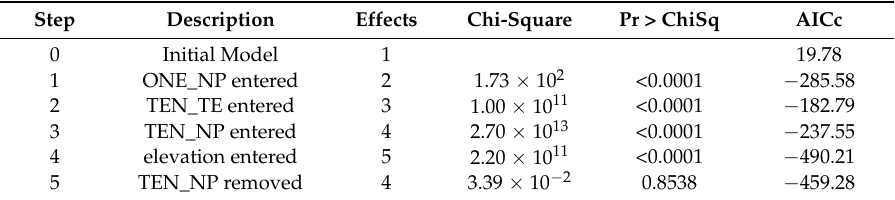
Table 4. Results from model selection analysis to explain variation in I. scapularis infection prevalence with B. burgdorferi as a function of land-use characteristics among 13 sites in central Virginia. All variables were significant at p < 0.01 but the five-parameter model indicated at step four was the model associated with the lowest AICc. Variable descriptions are found in Table 1.